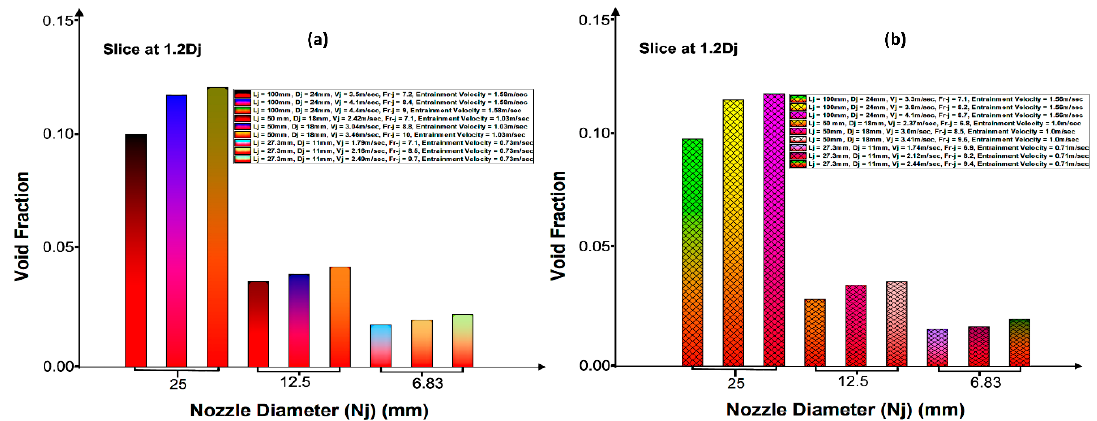
Figure 7. ( a ) VOF Simulated Values; ( b ) Chanson [39] Measured Values for a Peaked Void Fraction at 1.2 D j Depth.